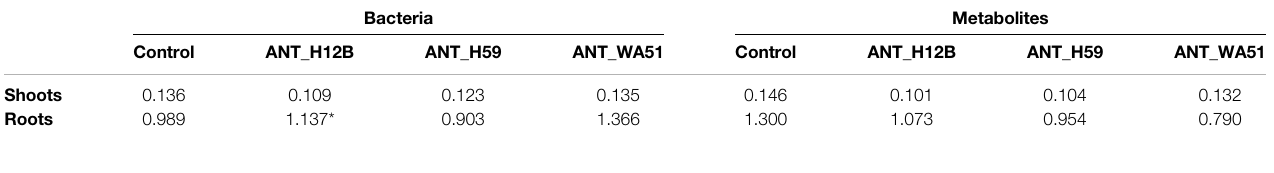
TABLE 3 | Iron content (µg/mg) in shoots and roots of plants after bioaugmentation with bacteria or application of metabolites. Presented results refer to the 21st day of the experiment. * — means statistical signi fi cance p < 0.05 compared to